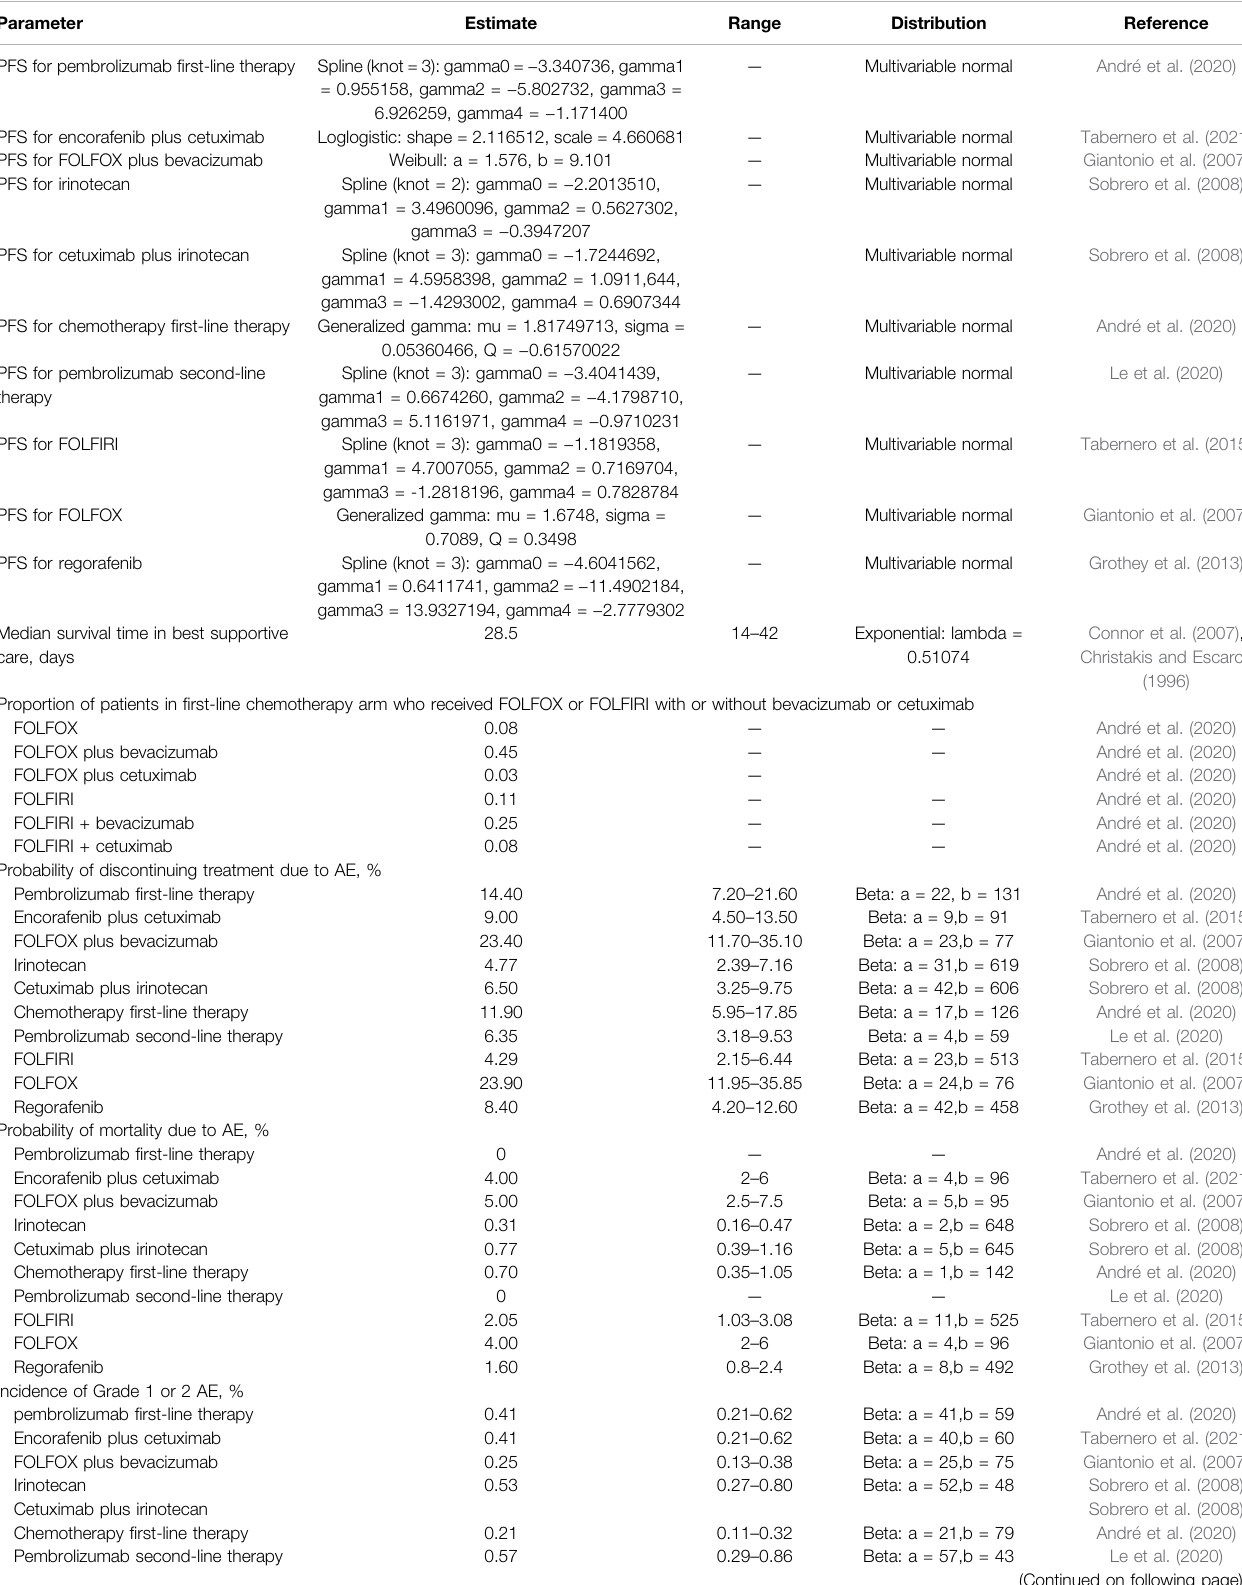
TABLE 1 | Model clinical